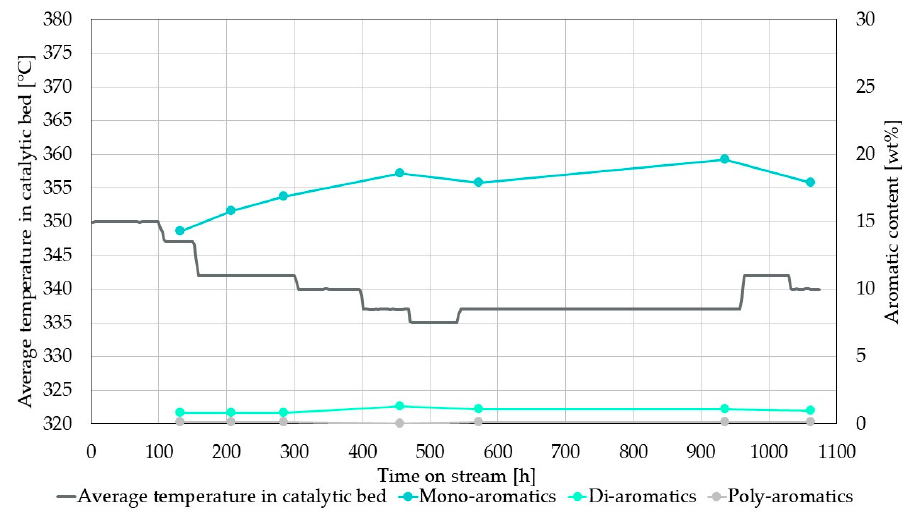
Figure 7. Influence of reaction temperature on the amount of aromatic compounds during the blank test.